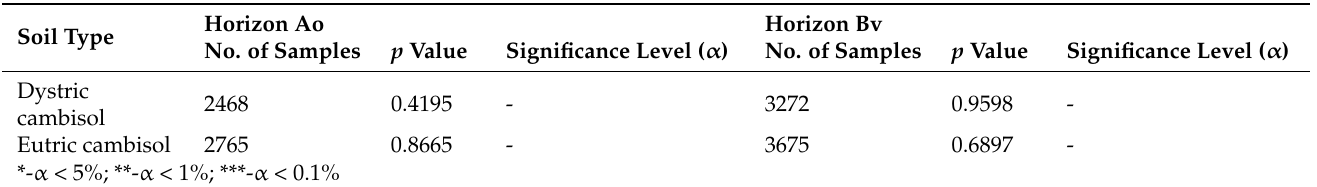
Table 1. Testing the significance among soil organic matter content of 4 different slope aspect categories for soil types as well as for the genetic horizon types.